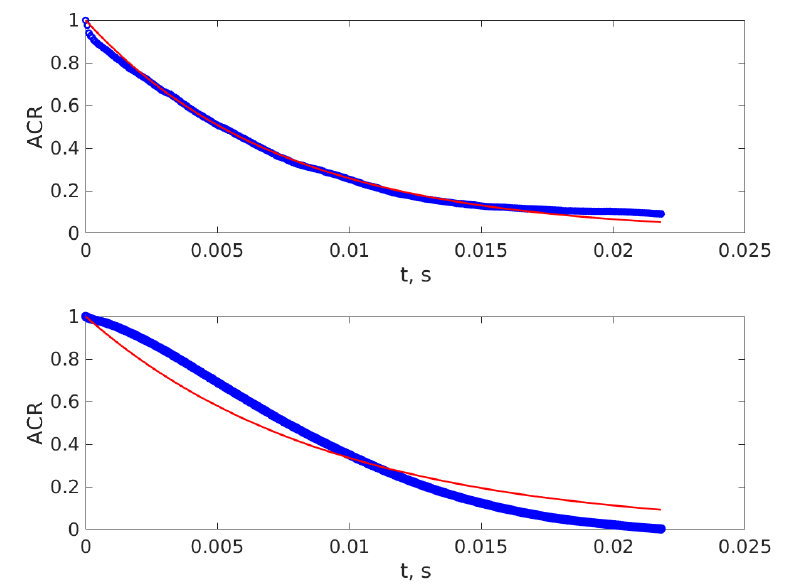
Figure 4. The ACR of two of the time series. The upper subplot illustrates an ACR that is well described by Equation (5) and the lower subplot the ACR that is the most departed from the ideal exponential decay described by Equation